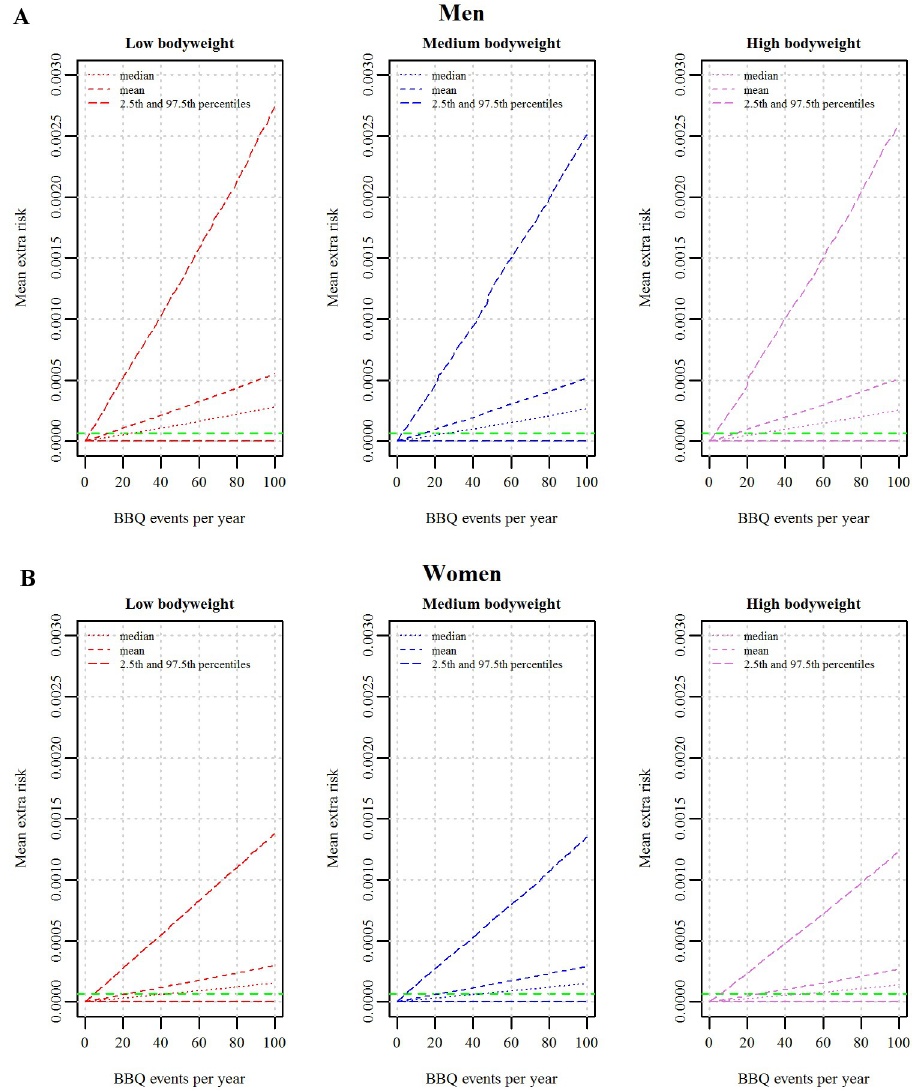
Fig 7. Uncertainty distribution of the mean extra lifetime risk of cancer as a function of events of consuming barbecued meat (BBQ events) for each sex and weight class. A: Men, B: Women. For each barbecue event, the uncertainty distribution of the mean risk is represented by the mean, median, 5 th and 95 th percentiles. Each value of the mean extra lifetime risk (500 uncertainty iterations) is the average of the 5,000 individuals (variability) in each subgroup for a fixed setting of the uncertainty. Green dashed lines represent the median of the mean risk from the population model.